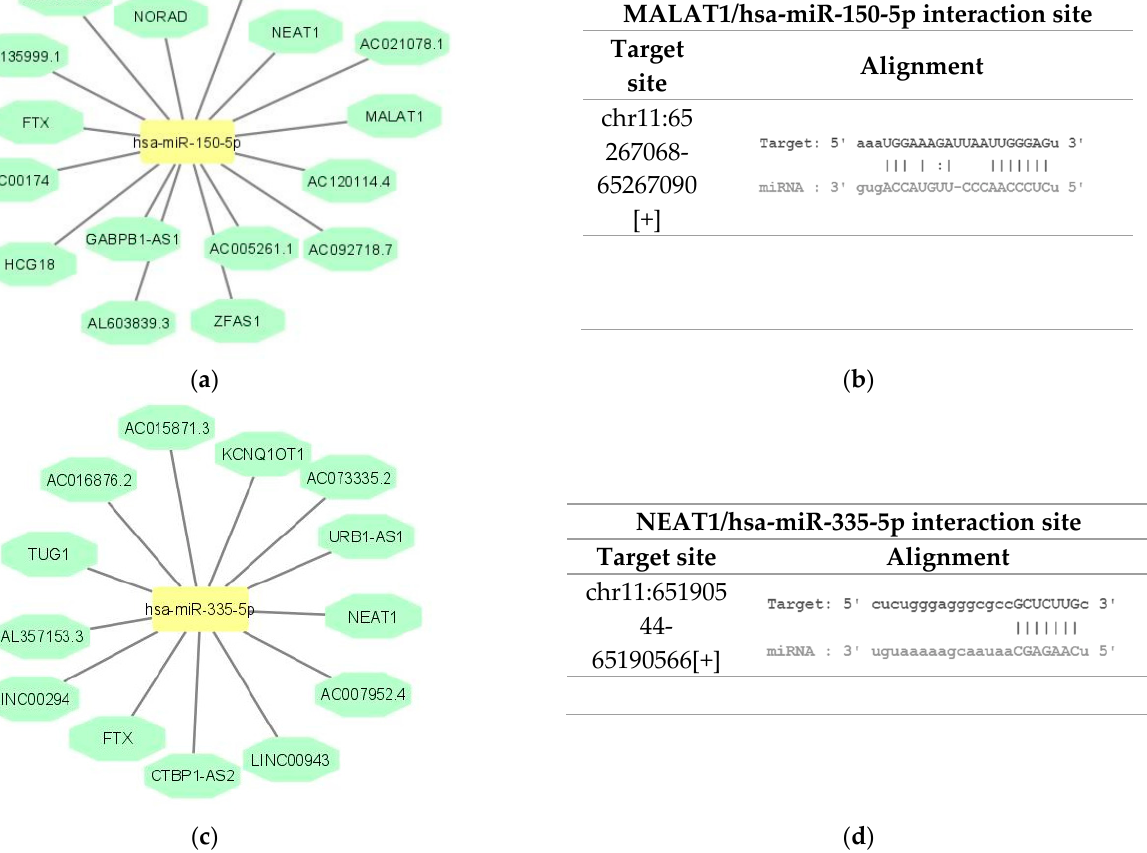
Figure 1. In silico analysis of the lncRNAs targeting hsa-miR-150-5p and hsa-miR-335-5p. ( a ) LncRNAs that target hsa-miR-150-5p according to StarBase database analysis; ( b ) details about the binding site of hsa-miR-150-5p on MALAT1, predicted by StarBase database; ( c ) lncRNAs that target hsa-miR-335-5p according to StarBase database analysis; ( d ) details about the binding site of hsa-miR-335-5p on NEAT1, predicted by StarBase